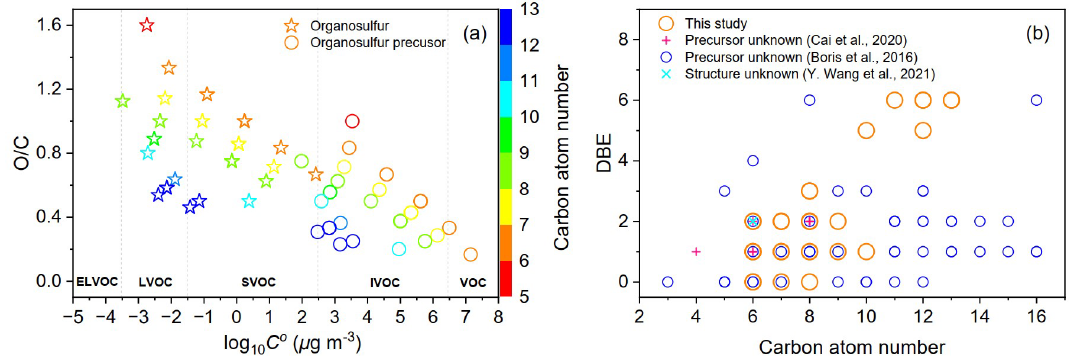
Figure 7. (a) Two-dimensional volatility–oxidation space of the identified organosulfurs and their precursors. (b) Carbon atom number distribution of organosulfurs observed in the current work and in the studies of Cai et al. (2020), Boris et al. (2016), and Y. Wang et al. (2021). Detailed formulae of these OSs can be found in Table S3. Organosulfurs from previous studies are of unknown origin or unknown